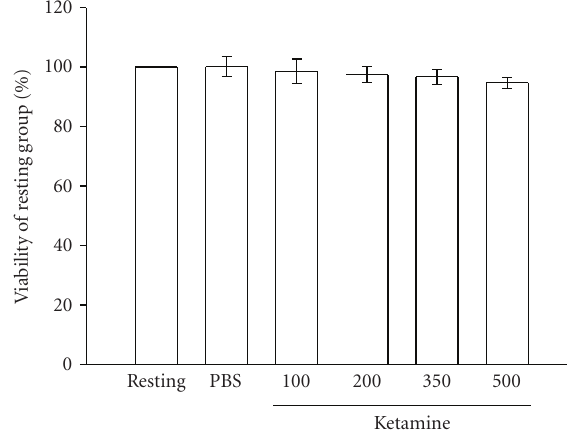
Figure 2: Tetrazolium dye 3-(4, 5-dimethylthiazol-2-yl)-2,5- diphenyl tetrazolium bromide (MTT) assay of ketamine-treated microglia. Microglia (5 × 10 5 cells mL − 1 ) were treated with various concentrations of ketamine (100 ∼ 500 μ M) or an isovolumetric PBS bu ff er for 24 hours. Cell viability was measured by a colorimetric assay at 550 nm based on the ability of mitochondria to reduce the MTT in viable cells. Data are presented as the means ± S.E.M. ( n =